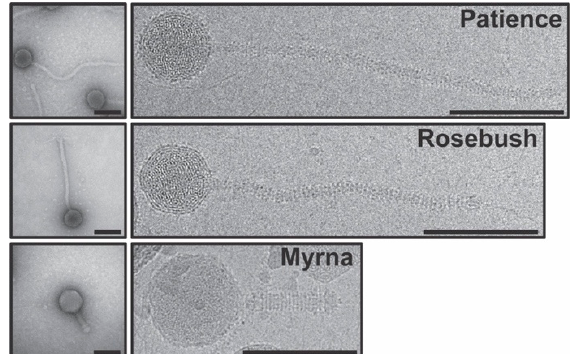
Figure 1. Electron microscopy (EM) of the actinobacteriophages. On the left are representative negative stain images of the three actinobacteriophages, Patience, Rosebush and Myrna, while the right shows representative cryo-EM images. Scale bar in the micrographs is 100 nm. The cryo-EM images are all at the same magnification (36,000×) and their sizes are directly comparable to one another. Bacteriophage dimensions are as follows. Patience head diameter: 66.7 nm, Patience tail length: 330.1 nm. Rosebush head diameter: 66.1 nm, Rosebush tail length: 252.5 nm, Myrna